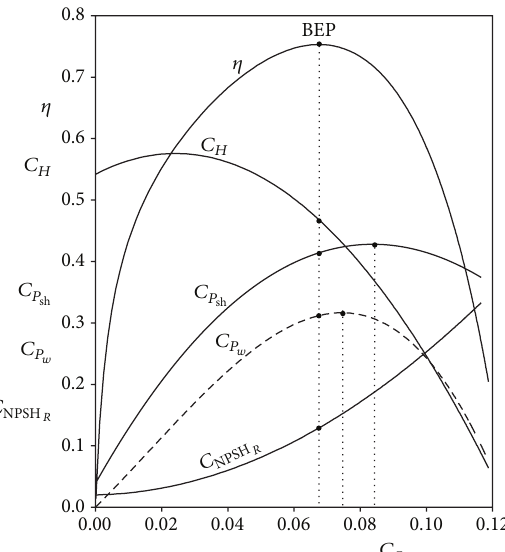
Figure 10: Characteristics of centrifugal pump obtained by present study.